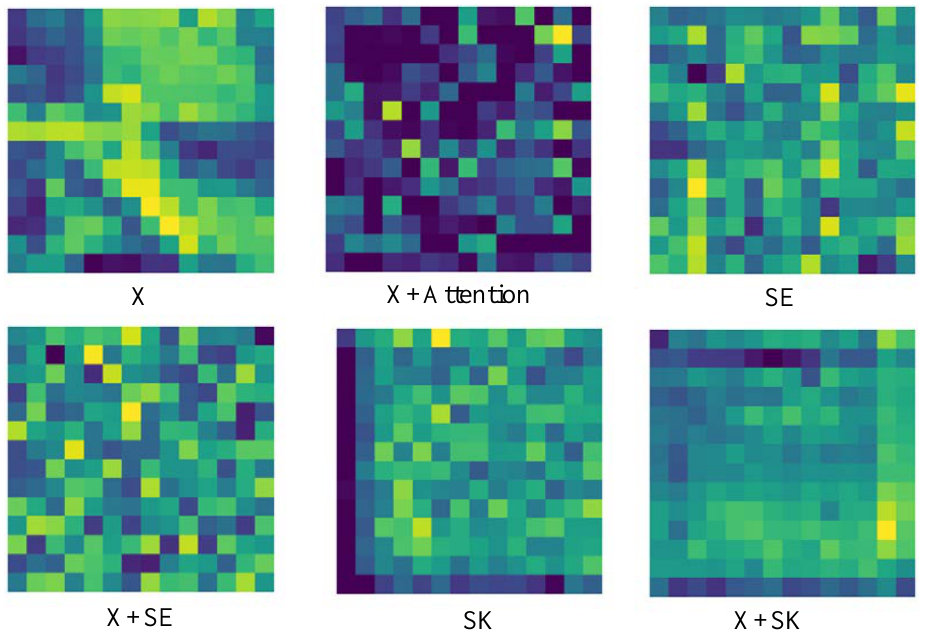
Figure 5. Differences between ASK-ViT, SE-ViT and ViT extracted features.